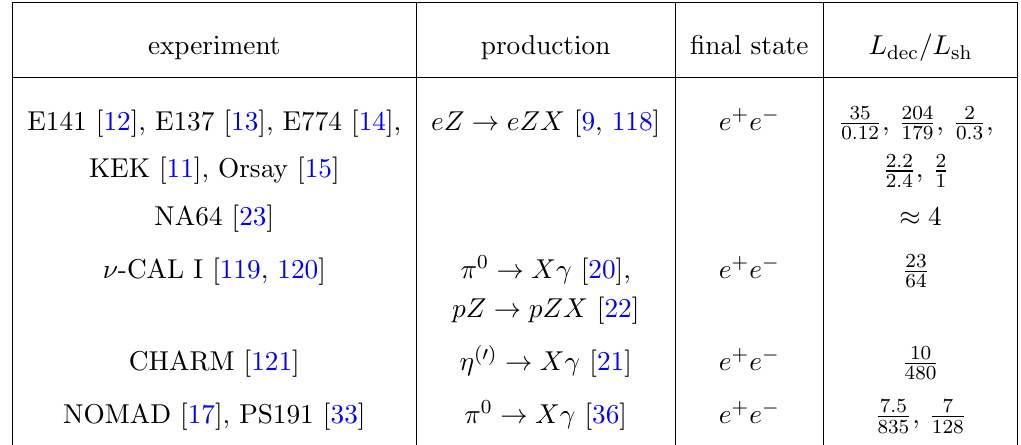
Table 5 . Summary of beam dump experiments that searched for long-lived dark photons.